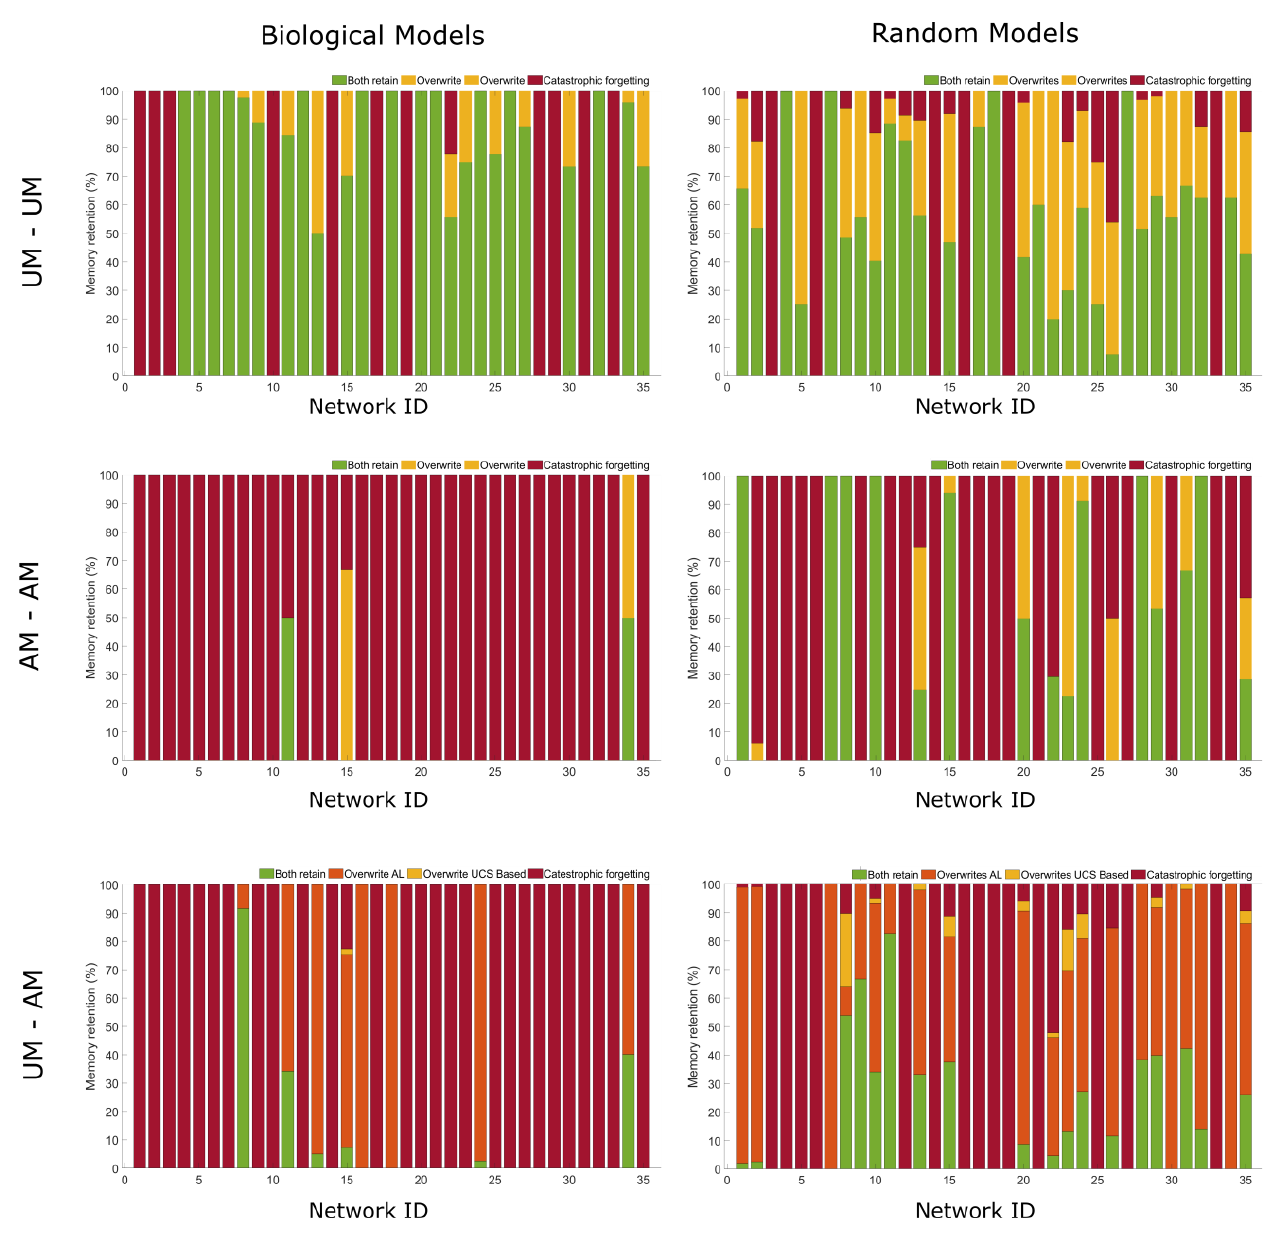
Figure 6. Parallel Memories in Biological and Random Models.